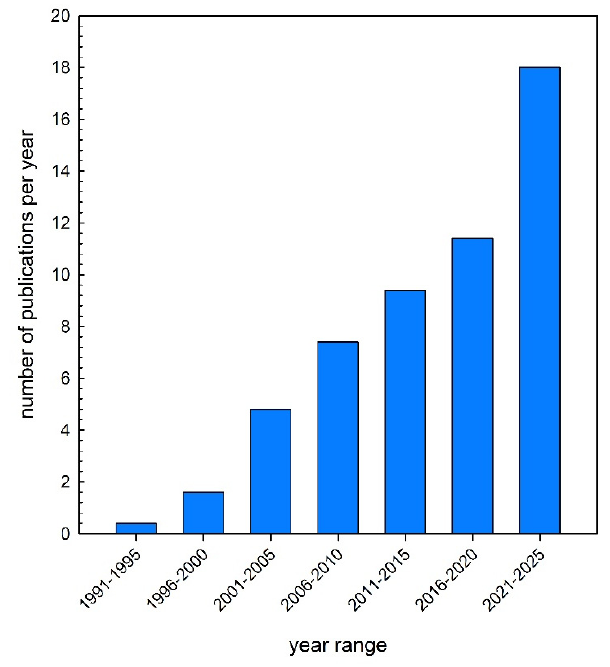
Figure 2. Temporal evolution of the number of publications per year focused on the topic studied and classified in five-year ranges.